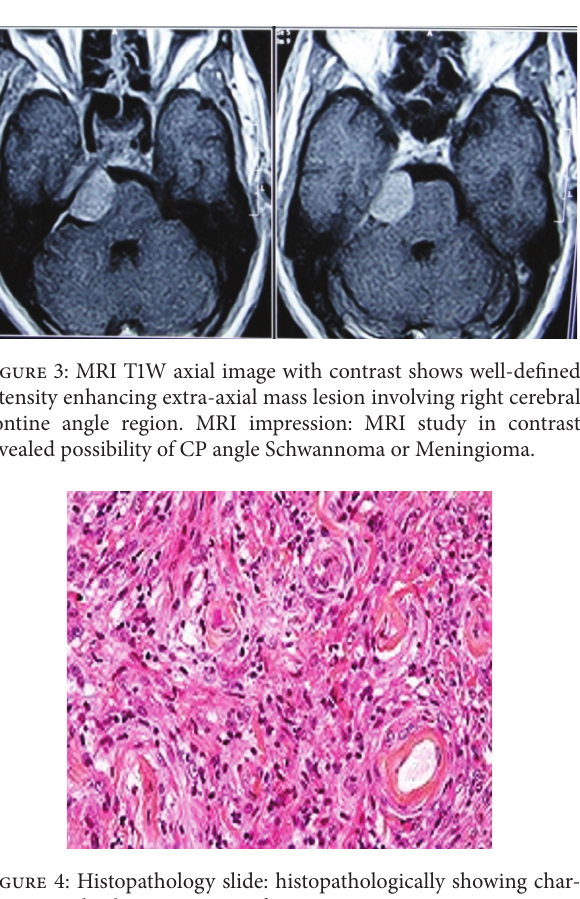
Figure 2: Flair axial image showing hyperintense, well-defined lesion seen in right cerebellopontine angle causing rotation of brain stem and compression of contralateral CP angle.